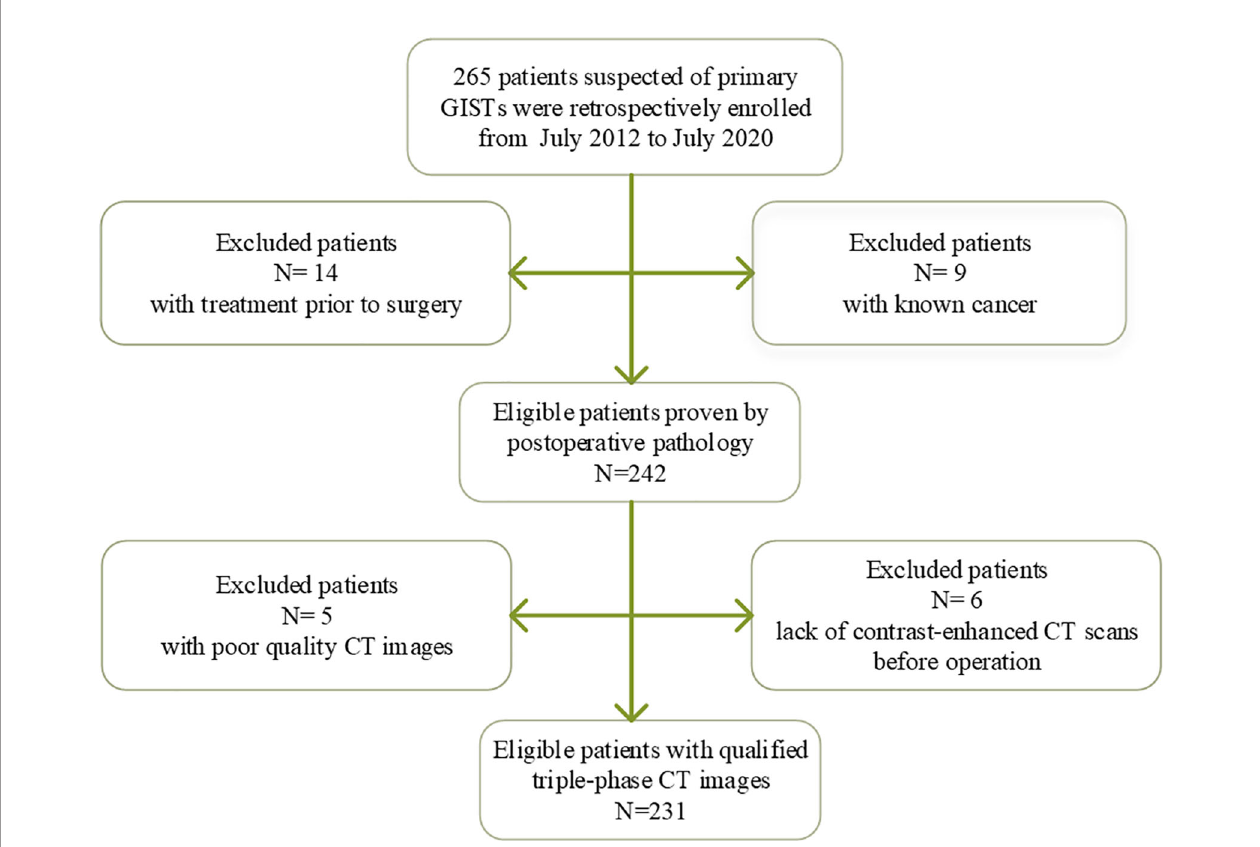
FIGURE 1 | The inclusion and exclusion criteria of